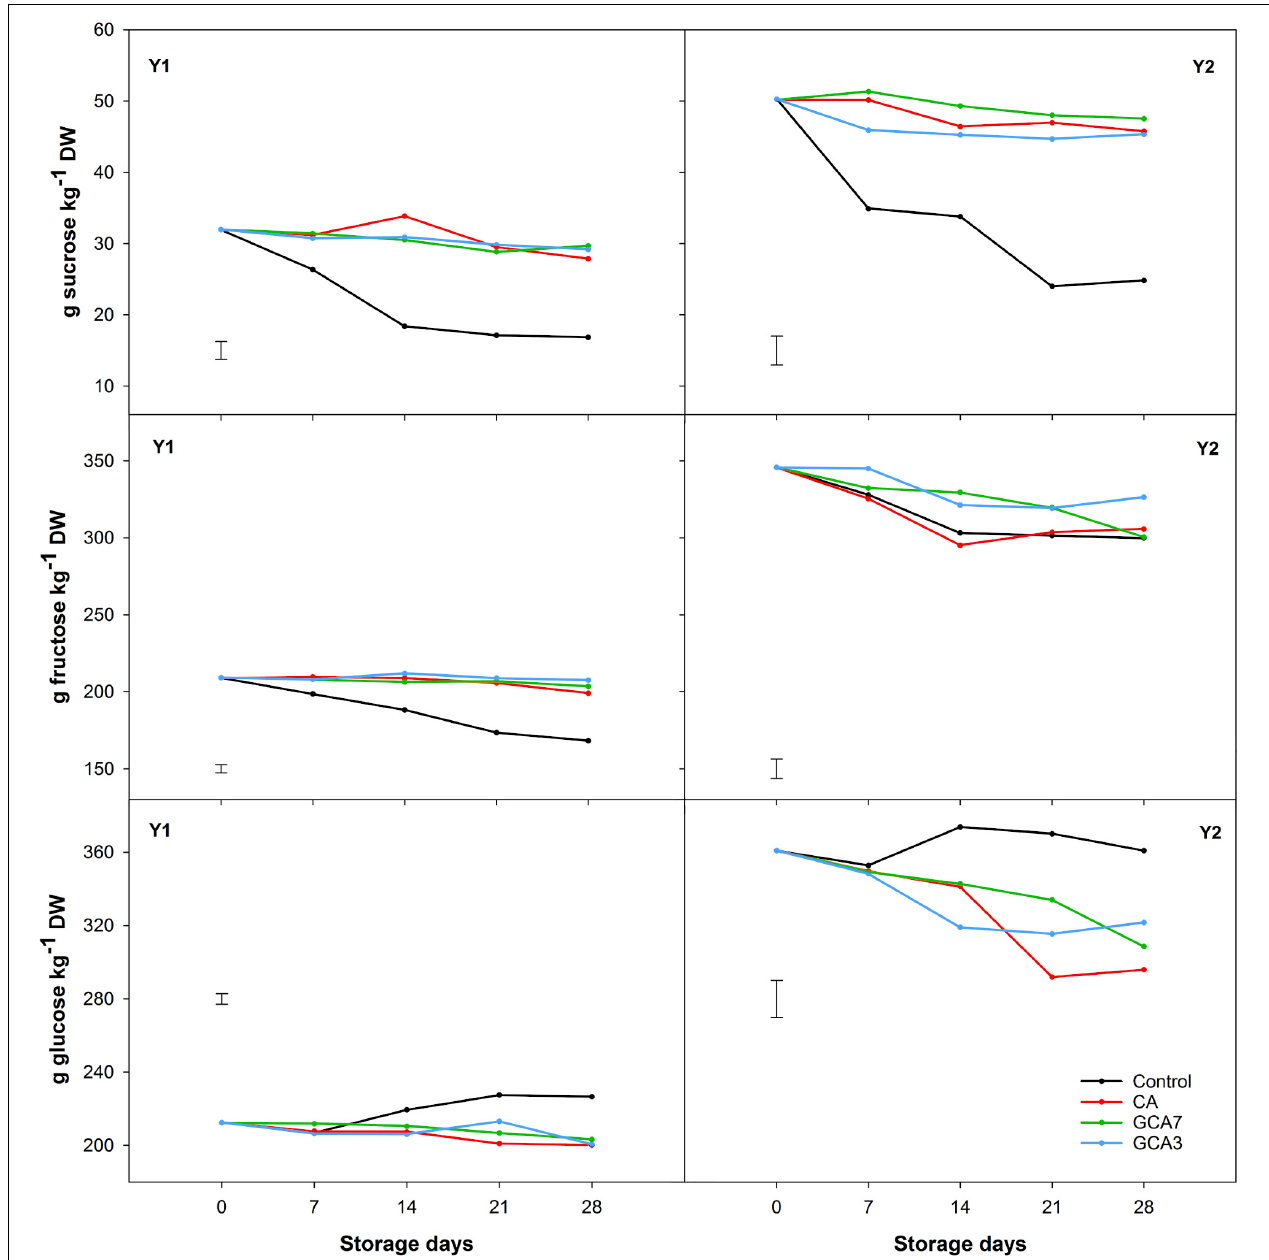
FIGURE 6 | Individual sugar concentration (sucrose, fructose, and glucose) expressed as g kg − 1 dry weight (DW) of “Duke” blueberry fruit subjected to controlled atmosphere (CA) applications throughout 28 days of storage at 0 ◦ C and 90–95 RH%; air [control]; standard CA (10 kPa CO 2 + 5 kPa O 2 ); graduated CA 7 (GCA7; 7 days to achieve standard CA values); and GCA3 (3 days to achieve standard CA values). Two consecutive seasons are considered 2017 (year 1; Y1) and 2018 (Y2). Data represents means ( n = 3). Least Significant Differences (LSD) are included as: (i) Sucrose – LSD treatment = LSD time = 2.484 for Y1 and LSD treatment = 4.082 for Y2; Fructose – LSD treatment ∗ day = 5.251 for Y1 and LSD treatment = LSD time = 12.63 for Y2; and Glucose – LSD treatment ∗ day = 5.848 for Y1 and LSD treatment ∗ time = 20.26 for